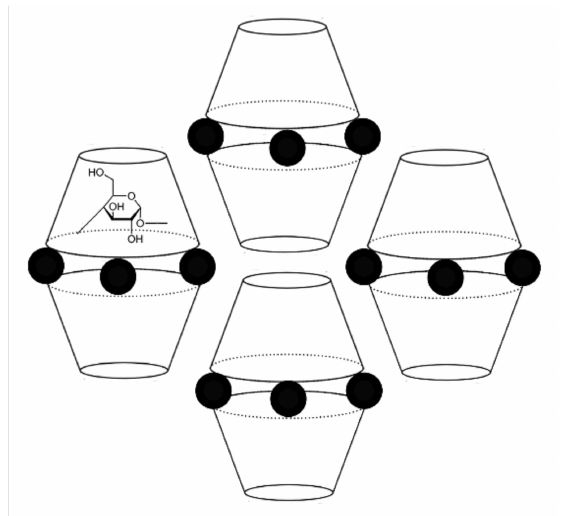
Figure 5. Side view of ε -phase sandwich-type dimers along the b-axis.